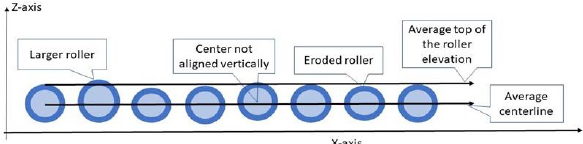
Figure 4. Issues in multiple rollers due to uneven erosion. Moreover, such measurements can be made at limited locations. Hence, more time and efforts would be required to manually measure the entire profile of the